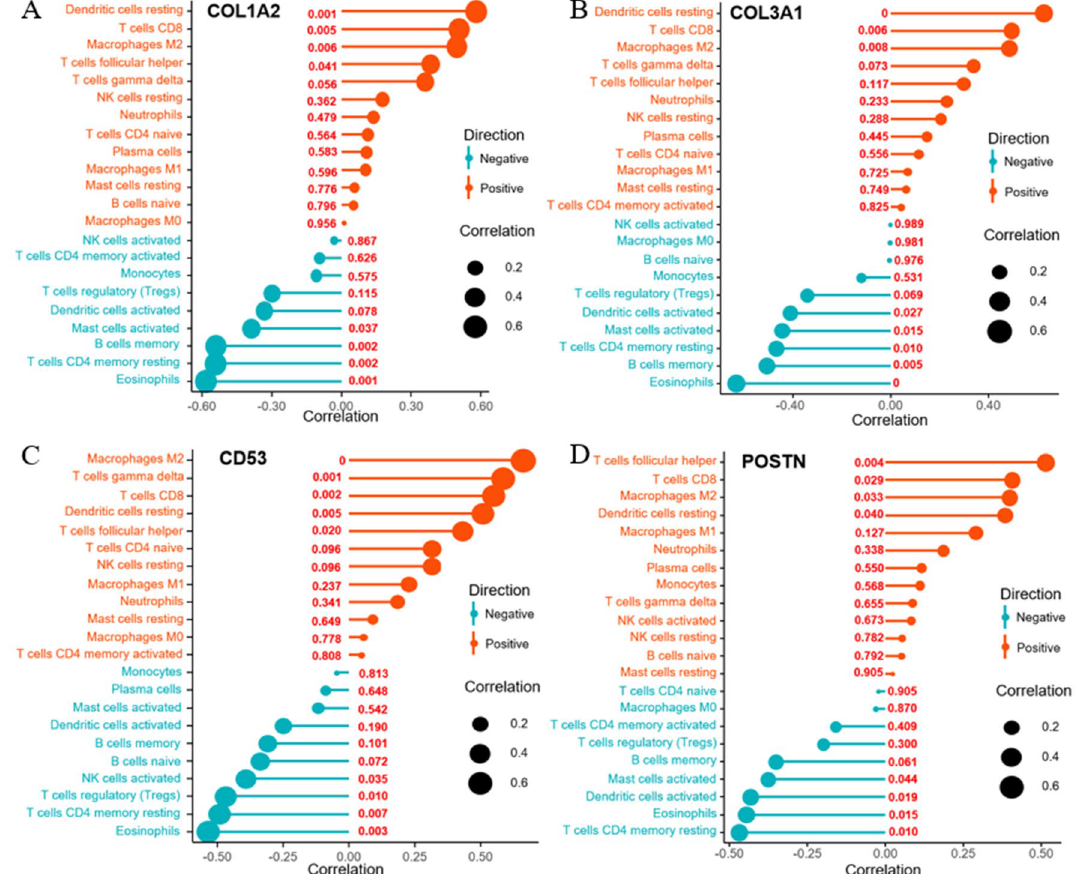
Figure 6. Correlation analysis of hub genes and infiltrated immune cells. The correlation analysis between infiltrated immune cells and four genes, including ( A ) COL1A2 , ( B ) COL3A1 , ( C ) CD53 , and ( D ) POSTN . P < 0.05 represented statistical